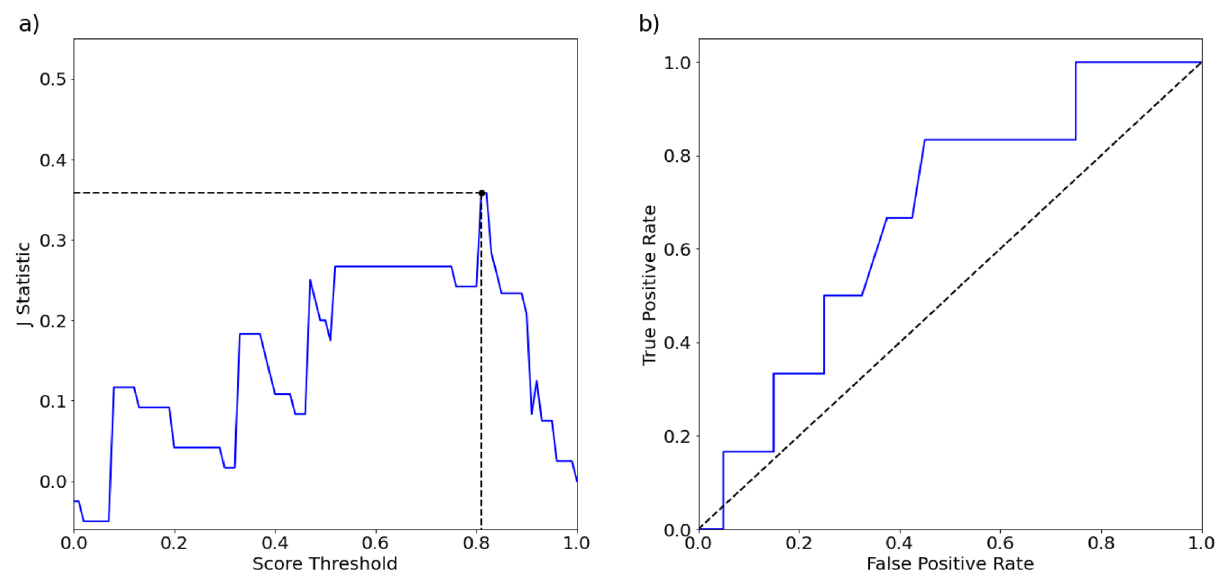
Figure 3. ( a ) Youden’s J statistic curve (blue) used to determine the score threshold. Optimal score threshold = 0.81 (J statistic = 0.36) is indicated by the dashed lines. ( b ) Receiver operator curve (blue) for prediction of revision surgery from load score dichotomization (area under the curve = 0.67). At the J statistic- determined threshold of 0.81, the false positive rate = 0.48 and true positive rate =